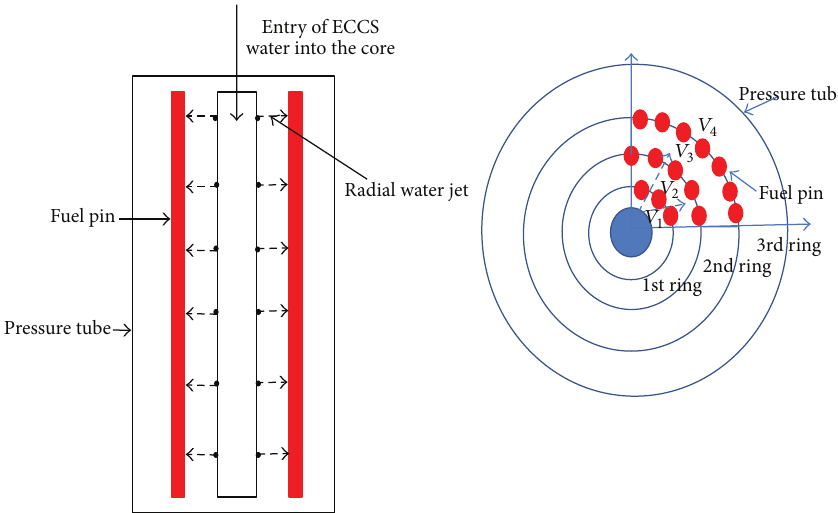
Figure 10: Influence of circumferential rewetting on fuel centre line temperature.